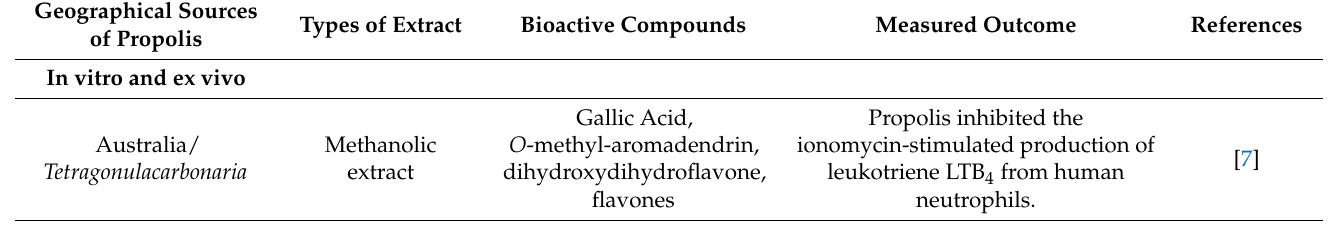
Table 1. Anti-inflammatory properties of propolis in terms ofimmune system